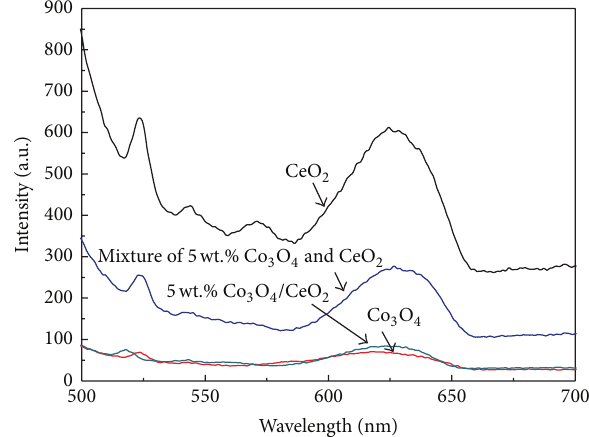
Figure 12: Photoluminescence spectra of CeO 2 , 5 wt.% Co 3 O 4 and CeO 2 mixture, and 5 wt.% Co 3 O 4 /CeO 2 and Co 3 O 4